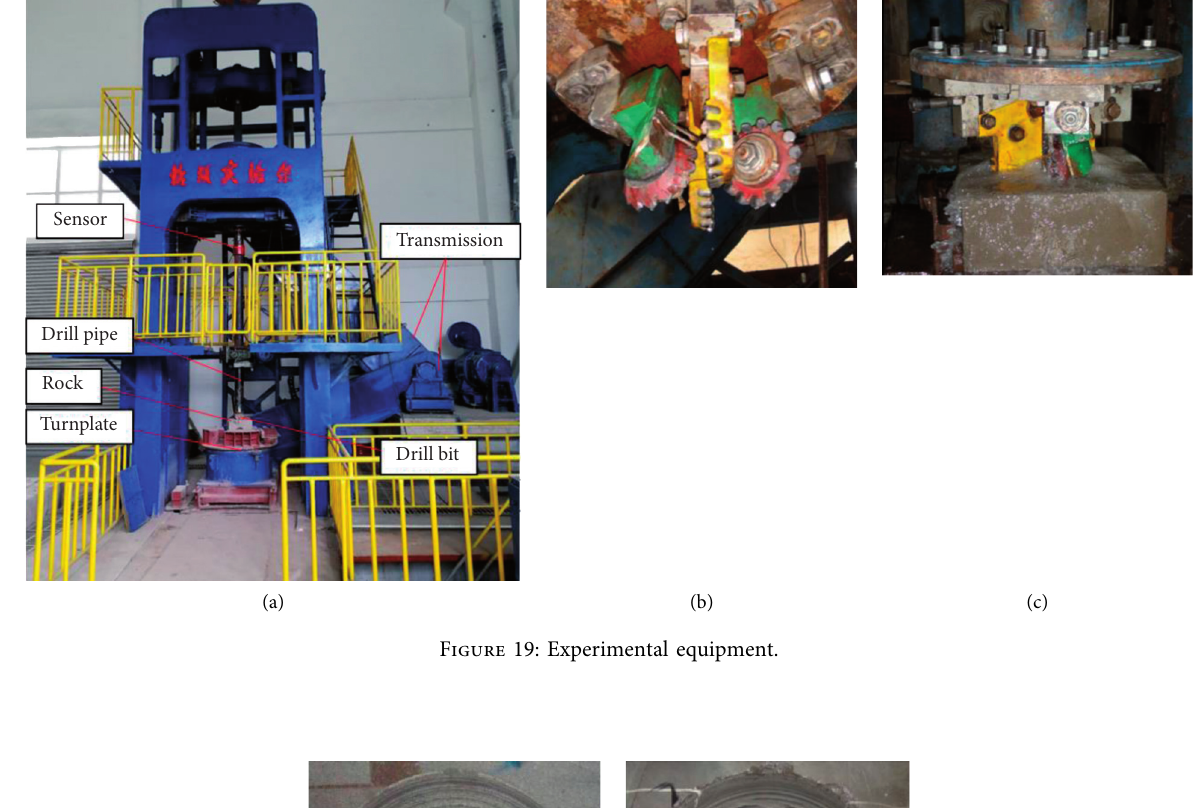
Figure 19: Experimental equipment.